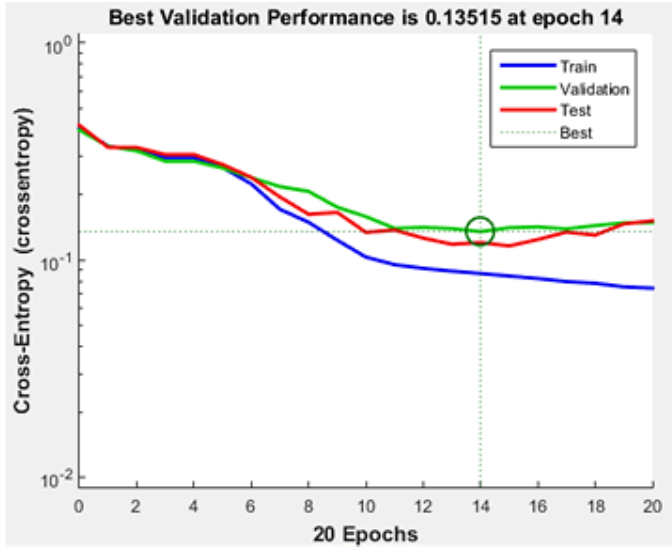
Figure 5. Validation Performance.